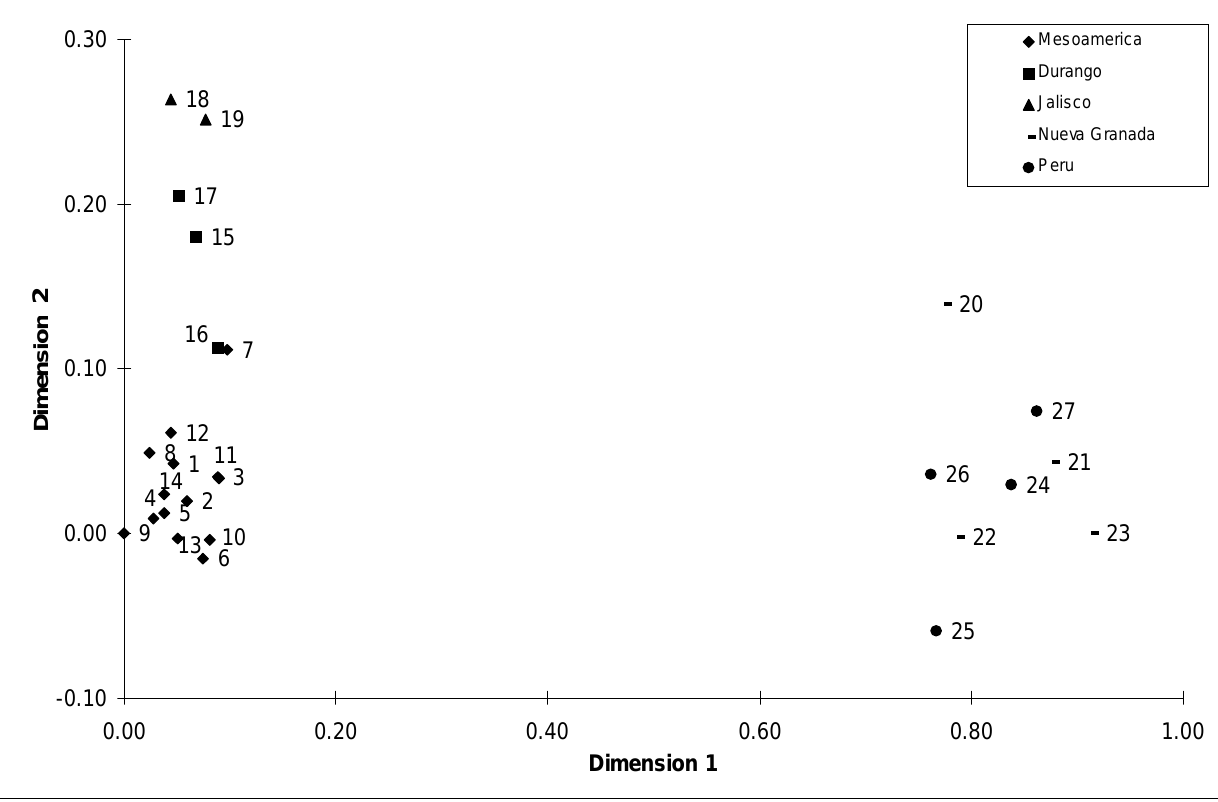
Figure 2 - Projection of the genetic distance between 27 common bean cultivars onto two-dimensional space. Identification of the cultivars is defined in Table